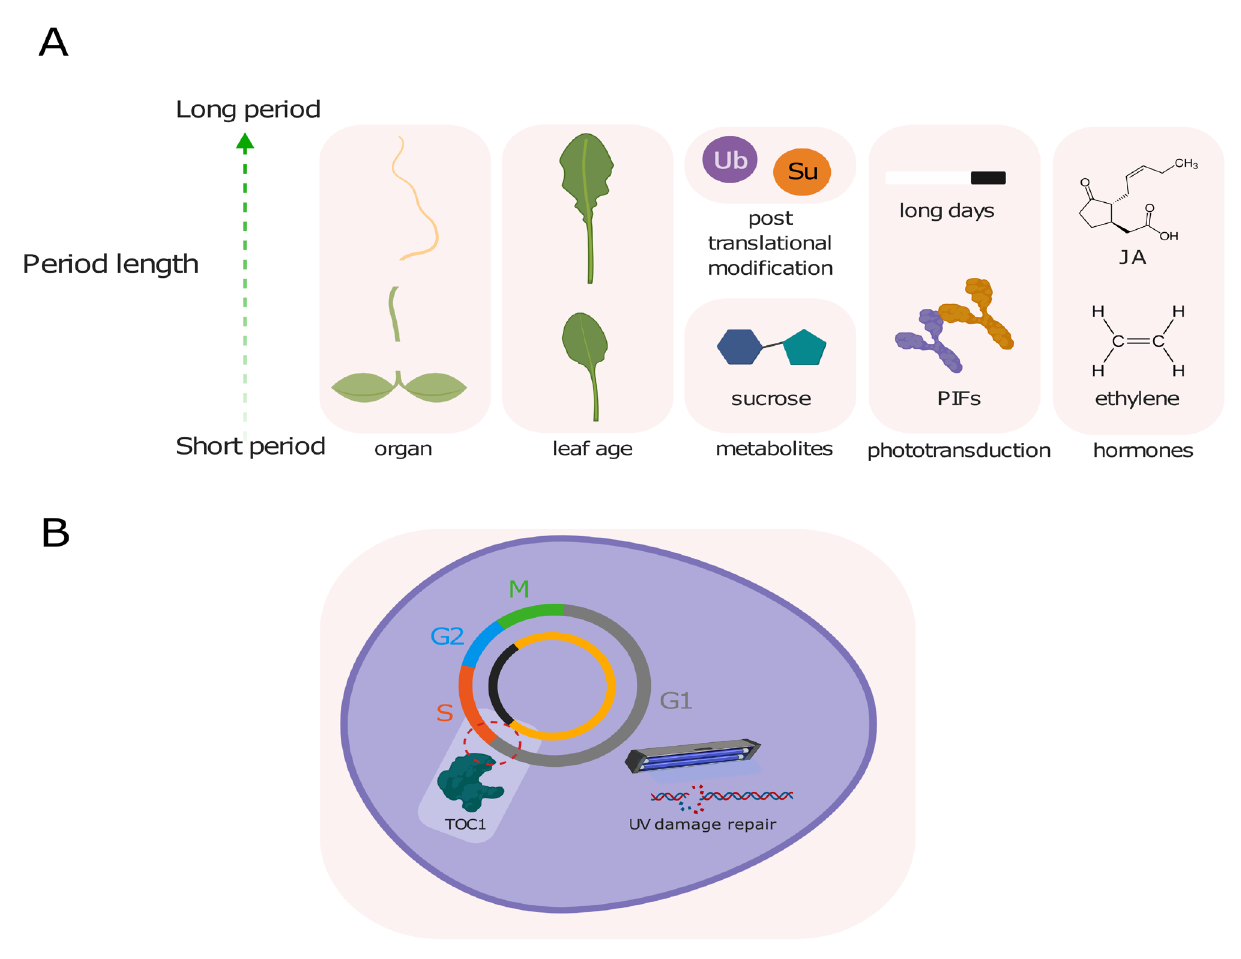
Figure 1. The period of the Arabidopsis thaliana circadian clock is regulated extensively by the cellular environment. ( A ) Cellular factors that affect the free-running period length of the Arabidopsis circadian clock include organ, age, post-translational modifications such as ubiquitination and SUMOylation, metabolites such as sucrose, hormones and phototransduction. ( B ) In turn, the circadian clock regulates the duration and integrity of the cell cycle, as entry into S phase around dusk is gated by the clock through TOC1, and DNA double-strand break repair occurs during G phase when transcription is active. JA, jasmonic acid; PIF, PHYTOCHROME INTERACTING FACTOR; Su, SUMOylation; TOC1, TIMING OF CAB EXPRESSION 1; Ub,